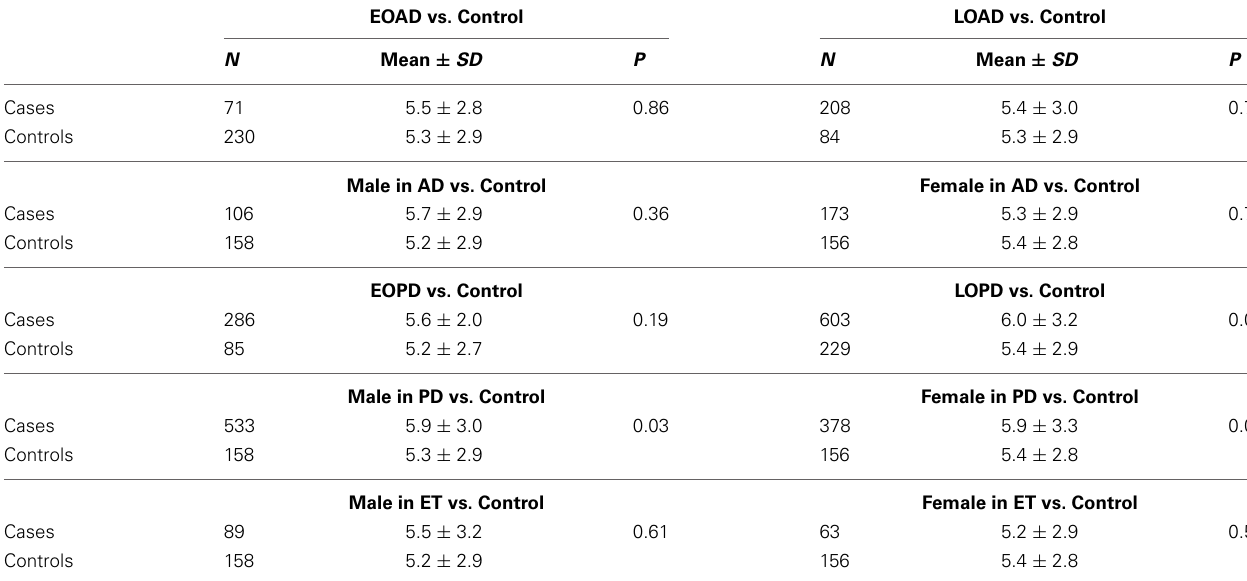
Table 2 | Analysis of the distributions of repeat expansion in cases with different classification.